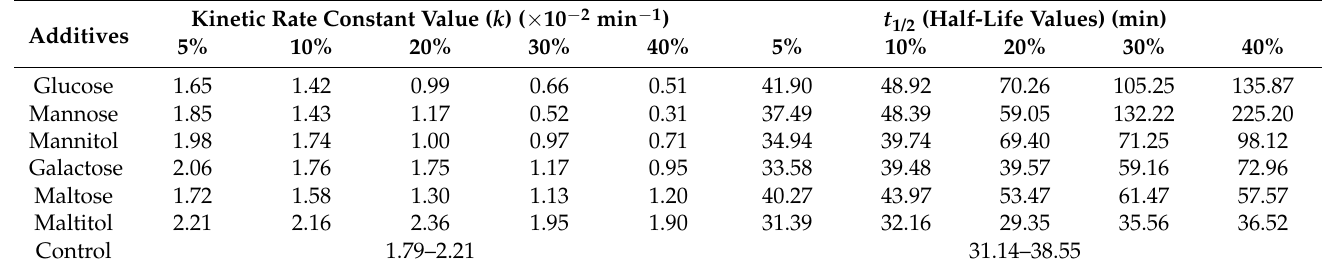
Table 1. The kinetic rate constant and half-life values of C-PC at 65 ◦ C with different additives.